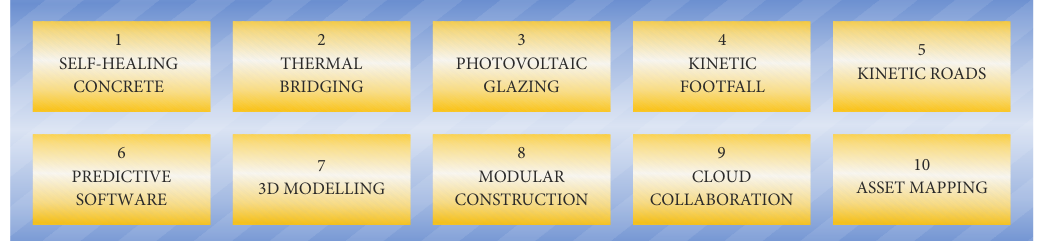
Figure 2. Innovations taking into account the augmented